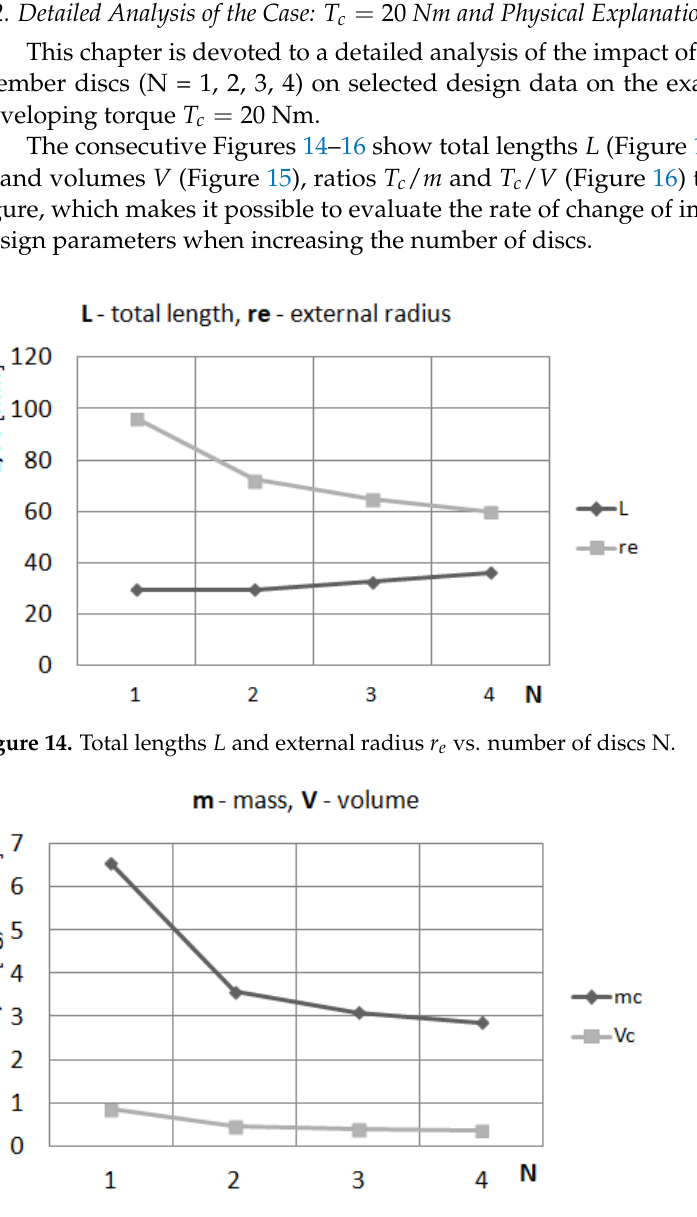
Figure 15. Mass m and volume V vs. number of discs N.